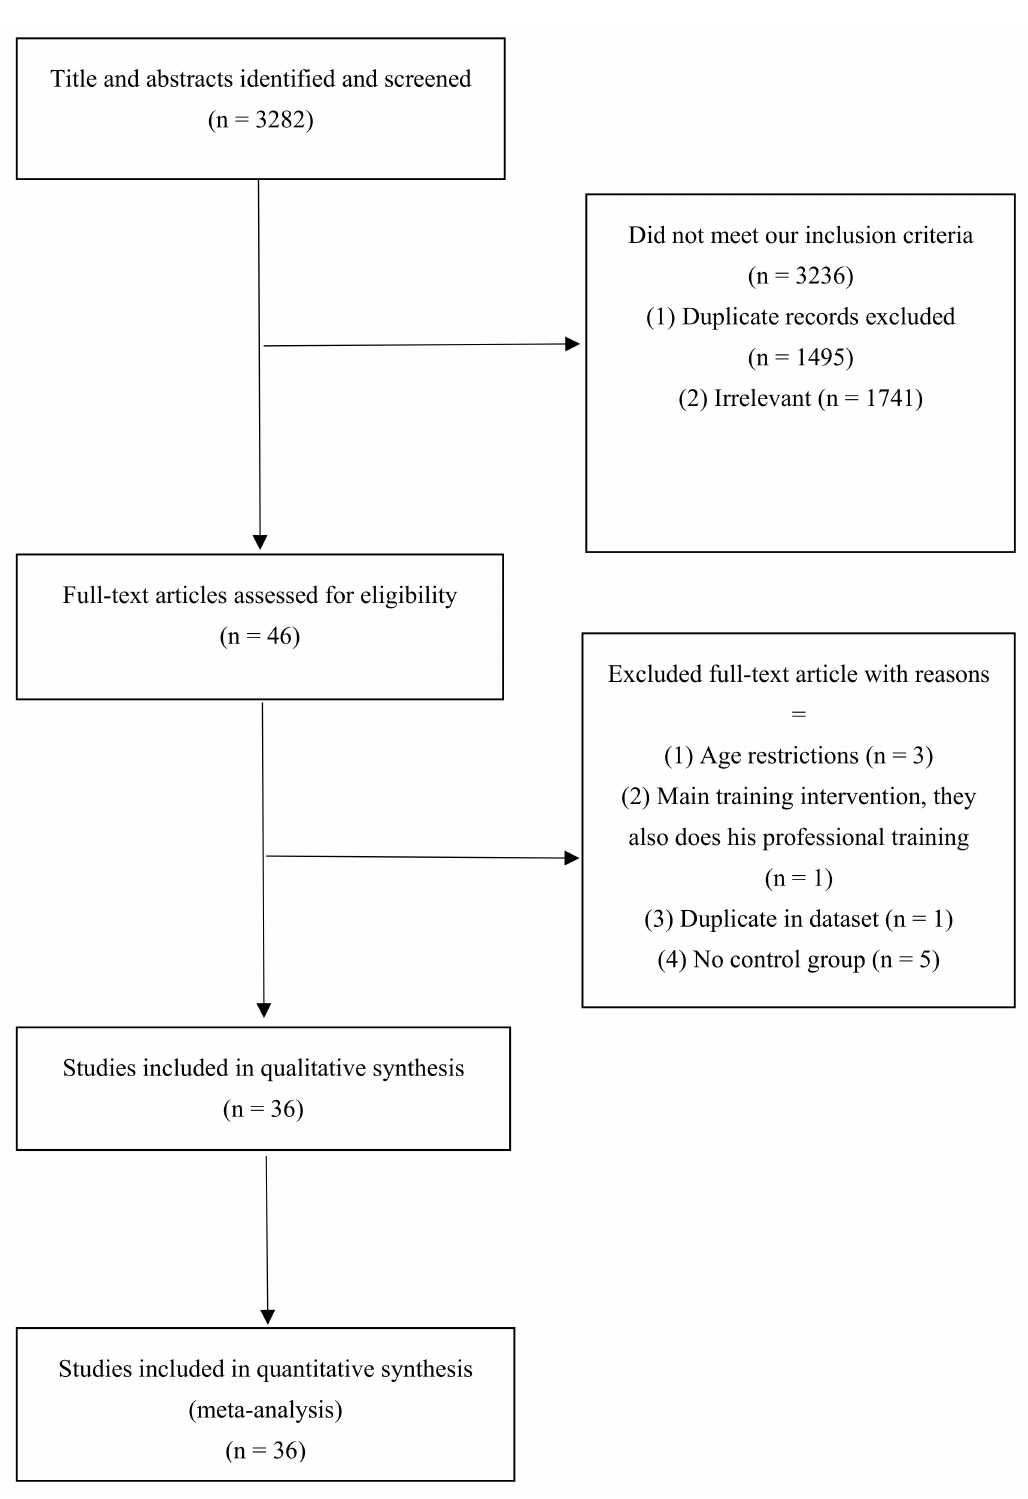
Figure 1. Flowchart of study selection for inclusion trials in the systematic